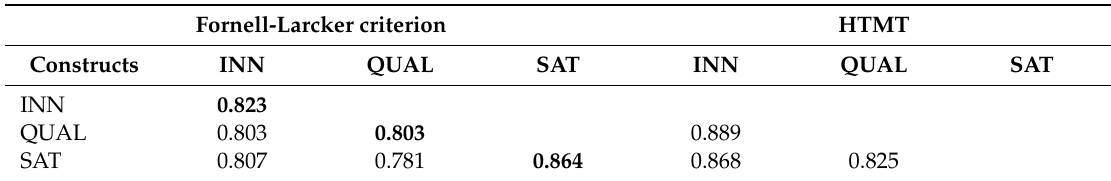
Table 7. Discriminant validity of the constructs.